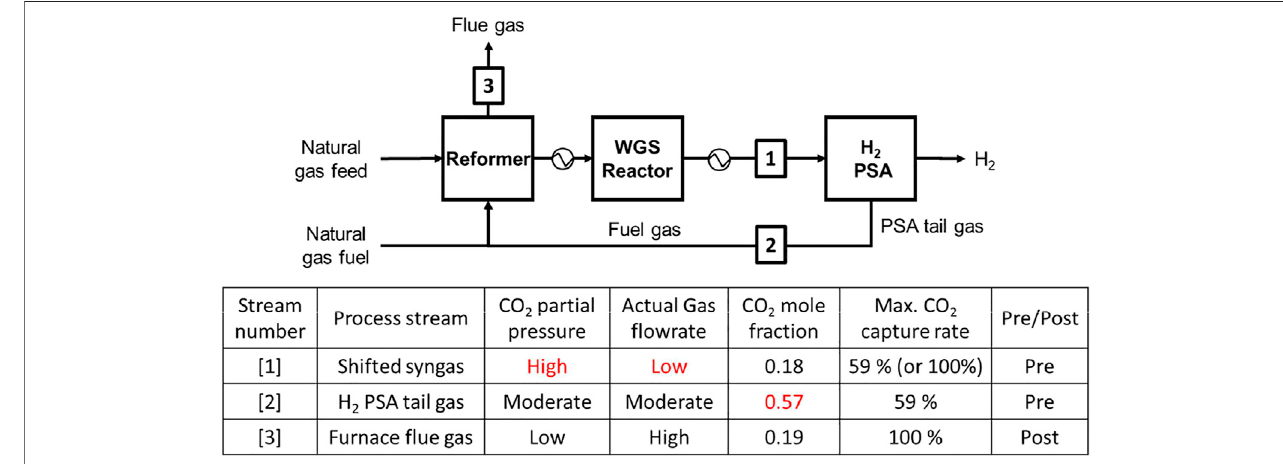
FIGURE 1 | Process fl ow of a SMR hydrogen production plant and three process streams where CO 2 can be captured.